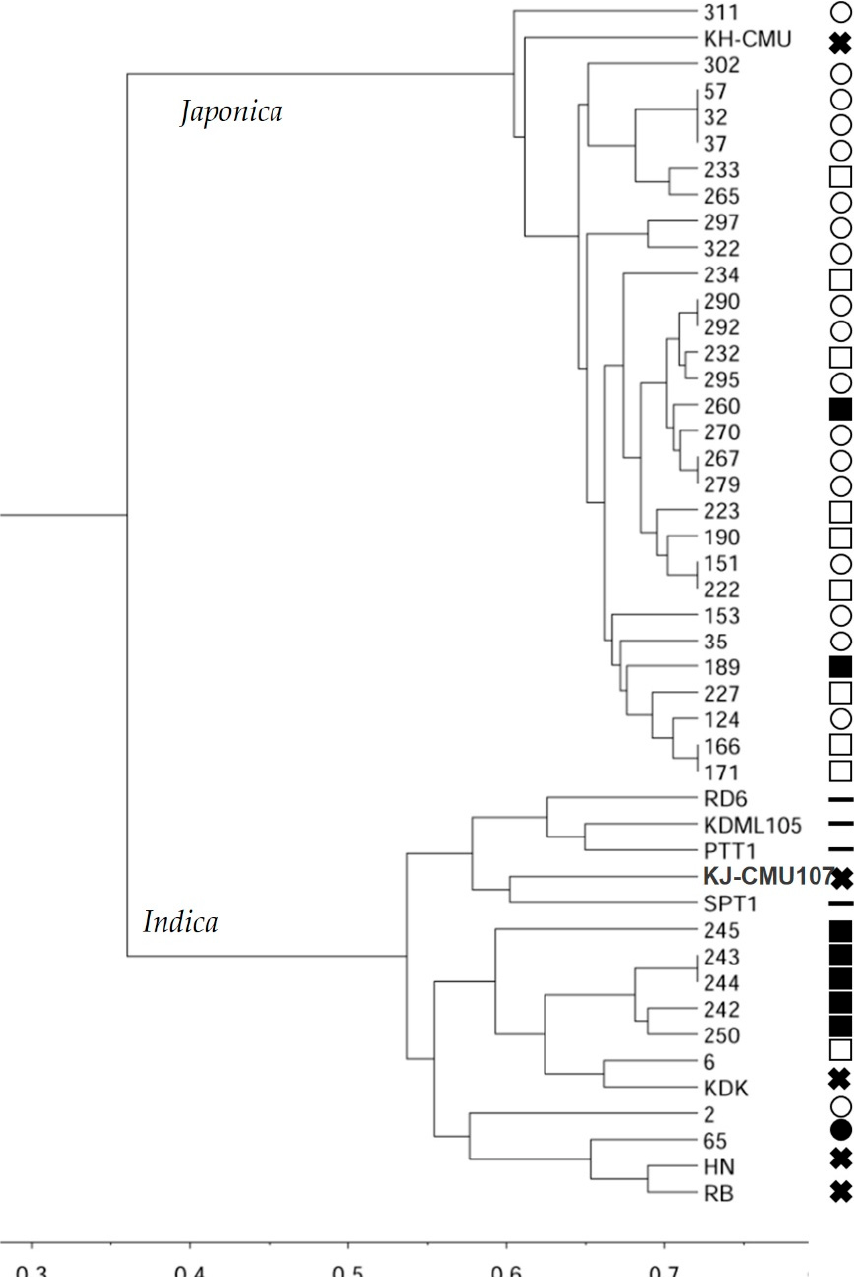
Figure 1. Cluster analysis using UPGMA method based on Nei’s genetic distance among 37 purple rice landrace and nine check varieties clustered into two main groups corresponding to indica and japonica . (The solid and transparent symbol represented upland and wetland rice respective; the circle and square symbol represented the highlands and lowlands, respective; the solid cross and minus represent the purple rice check and colorless check varies, respectively).